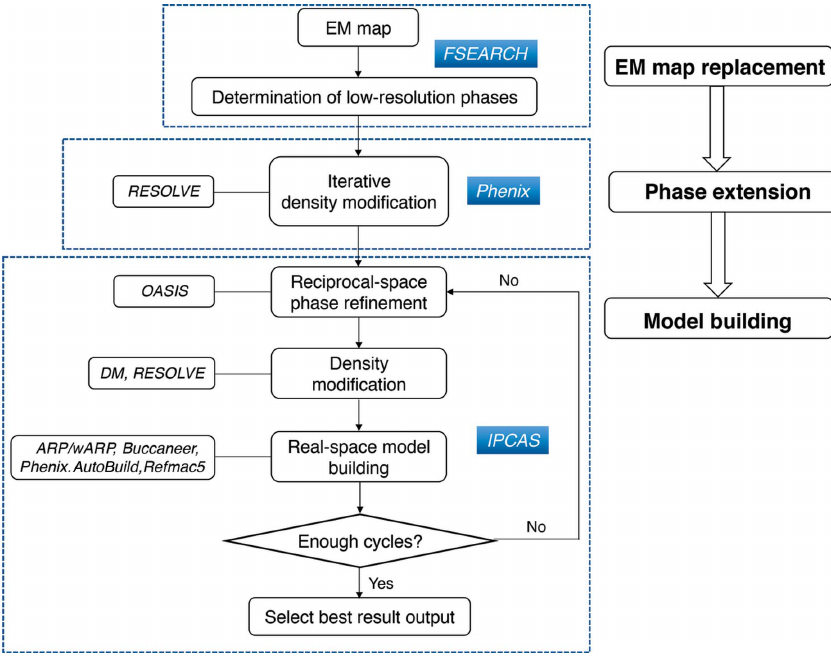
Figure 1 Workflow of a hybrid method integrating X-ray crystallography with cryo-EM for structure